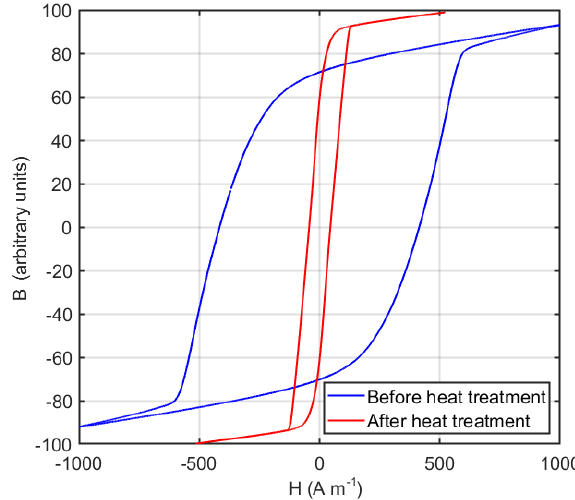
Figure 15. B – H loop of permalloy ring cores before (blue) and after (red) heat